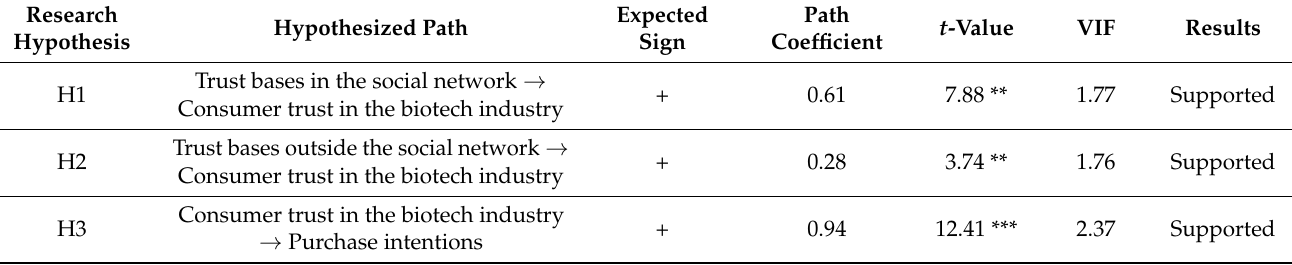
Table 6. Summary of the Tested Hypotheses 1–3.